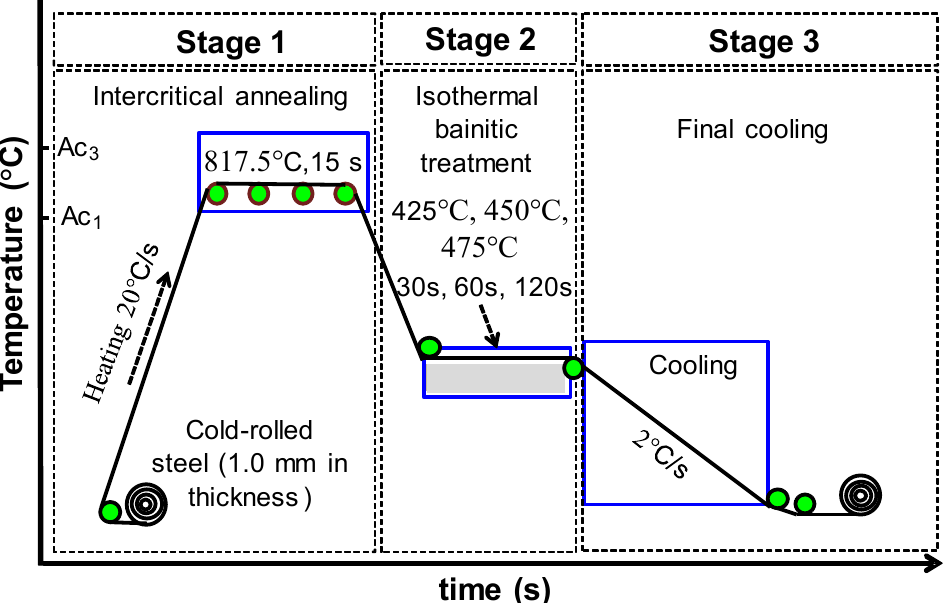
Figure 1. Schematic representation of thermal cycles and processing variables used to produce multiphase steels.